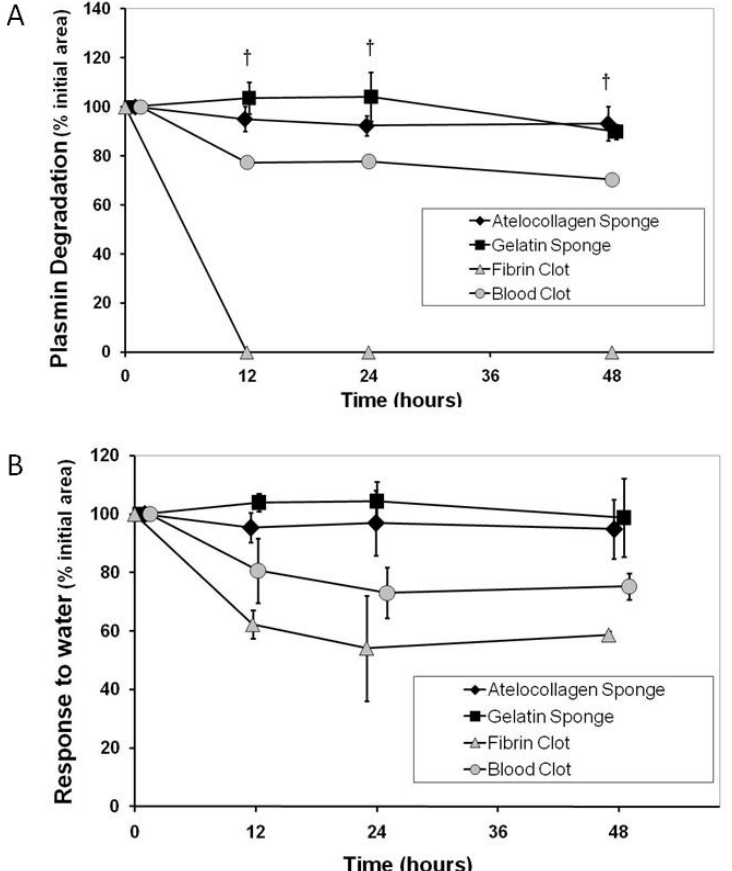
Figure 2. Enzymatic degradation of atelocollagen, gelatin, fibrin, and blood clot scaffolds over a 48 h period by ( A ) plasmin and ( B ) water (control). † denotes significantly less degradation by plasmin of atelocollagen and gelatin scaffolds than the blood clot or fibrin clot (p < 0.05 for all